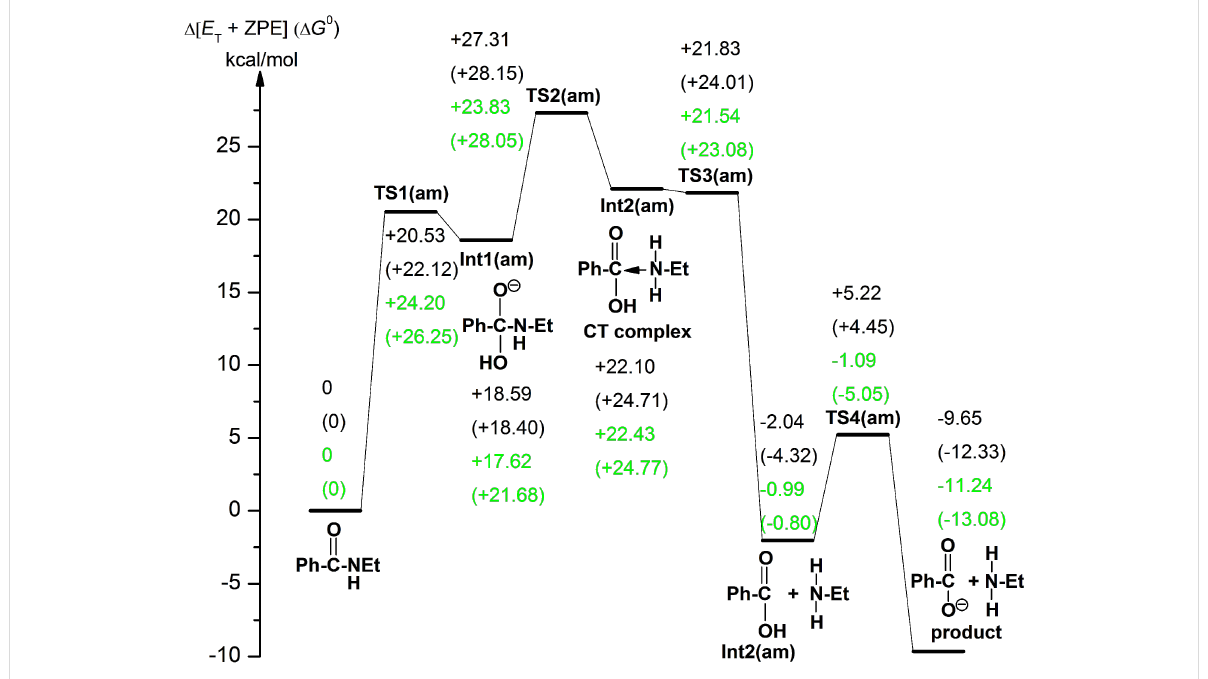
Figure 8: Changes of Et + ZPE and (Gibbs free energies) of the amide hydrolysis in Figure 5 and Figure S4 (Supporting Information File 1). Energies in green are for the Na + -containing reaction in Figure